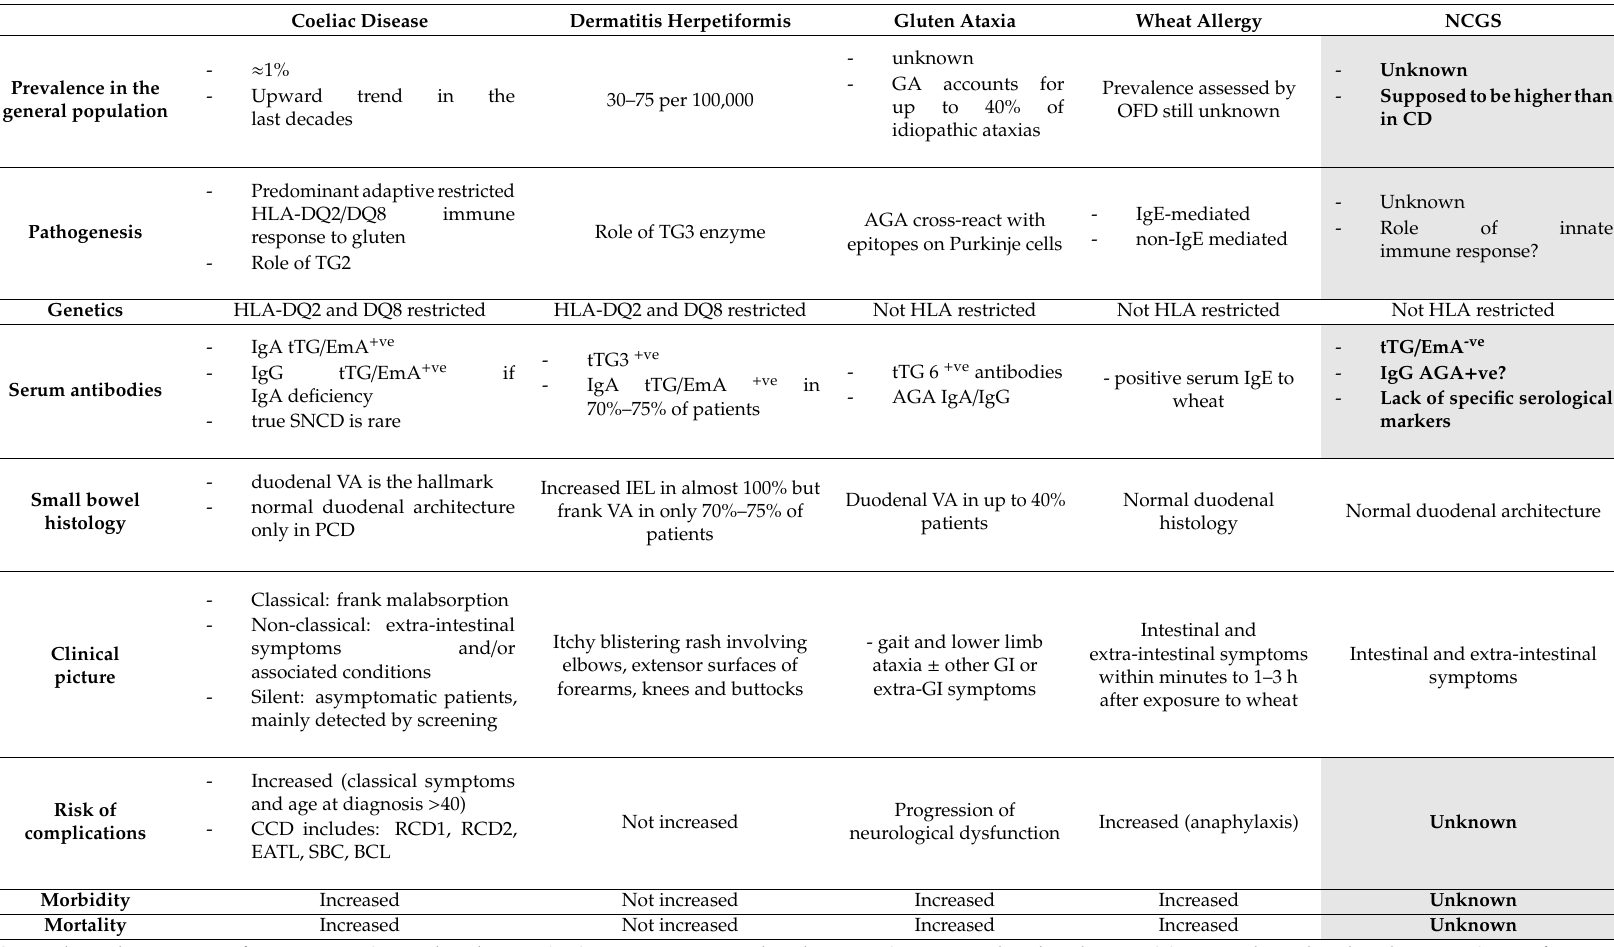
Table 1. Comparative overview on clinical, pathological, and epidemiological features of the di ff erent types of gluten-related